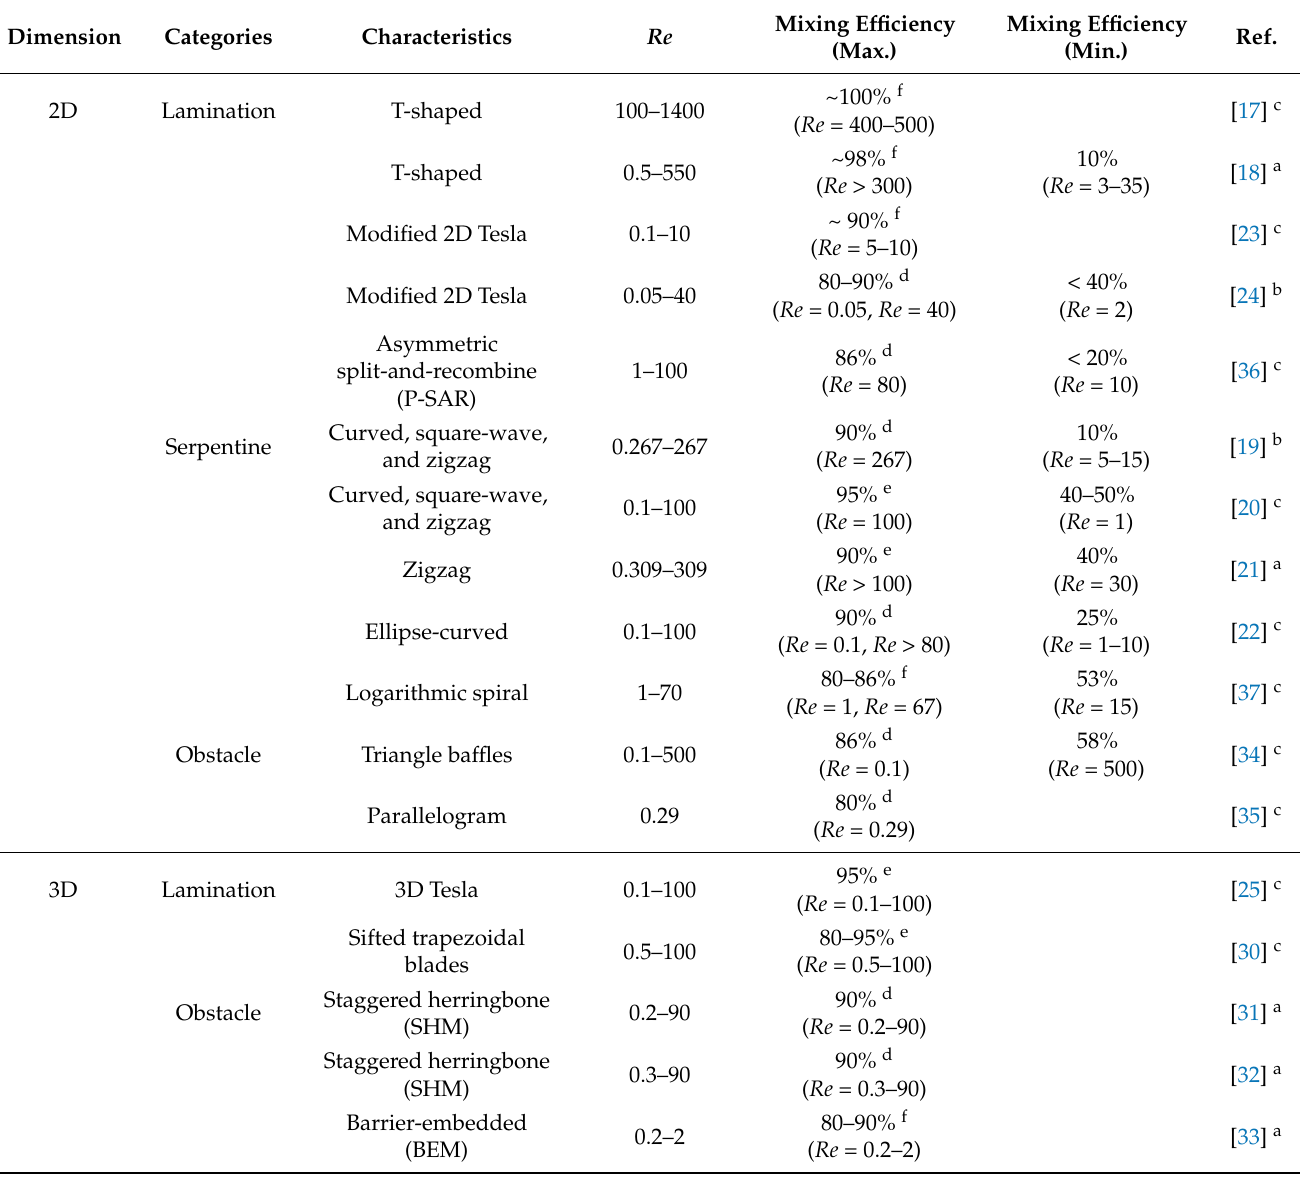
Table 1. Mixing efficiencies of representative passive